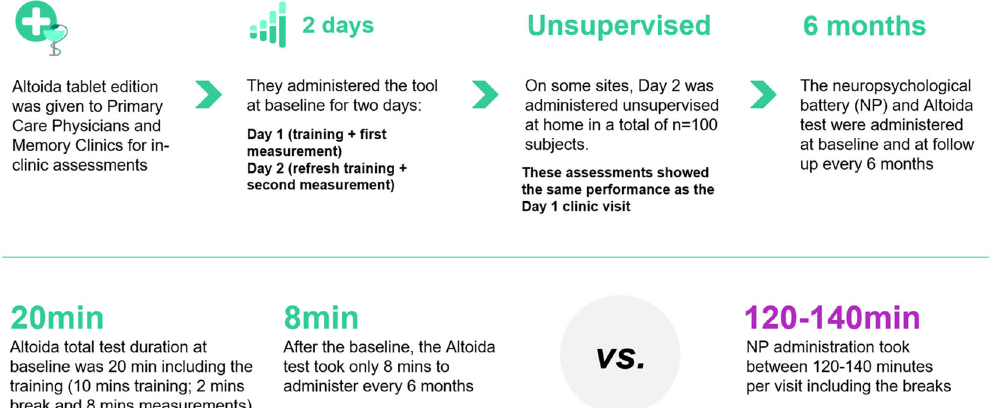
Fig. 4 An overview of the procedure used in both studies, except for the unsupervised Altoida DNS use, which was conducted only in Study B in HCs and participants with